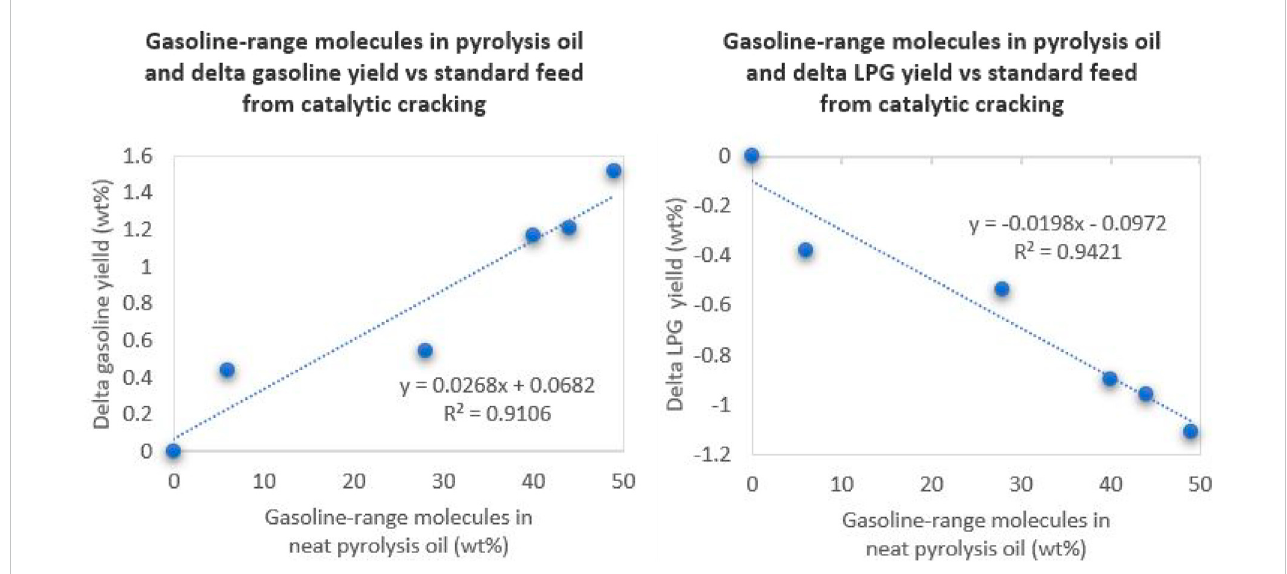
FIGURE 3 Correlations between gasoline-range molecules in the pyrolysis oils and resulting gasoline (left) and LPG (right) yield deltas from the catalytic cracking evaluations.